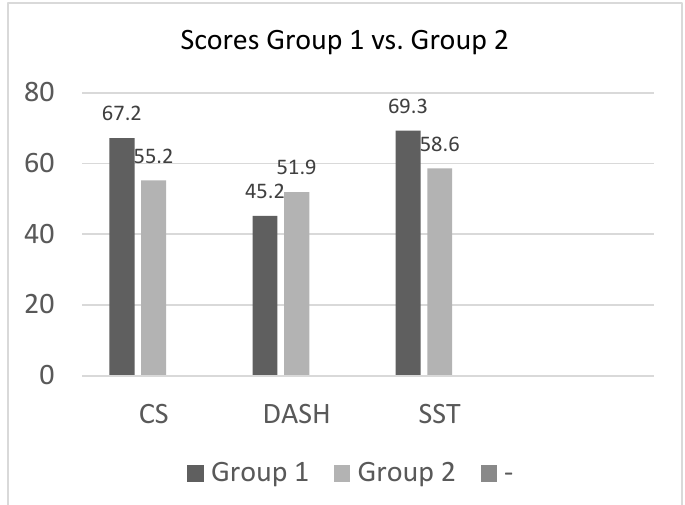
Figure 3. Scores comparing group 1 and group 2. Figure 4. Scores comparing group 1 and group Table 5. Scores comparing group 1(anatomical/acceptable fracture reduction) and group 2 (malre- duction).